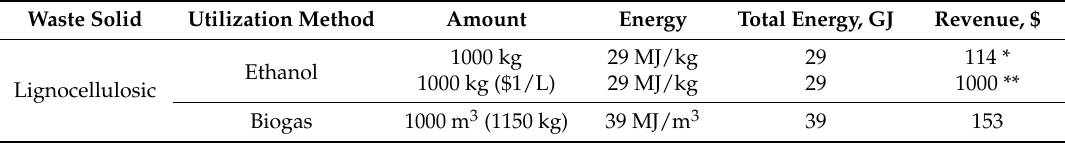
Table 3. Revenue generated from ethanol and